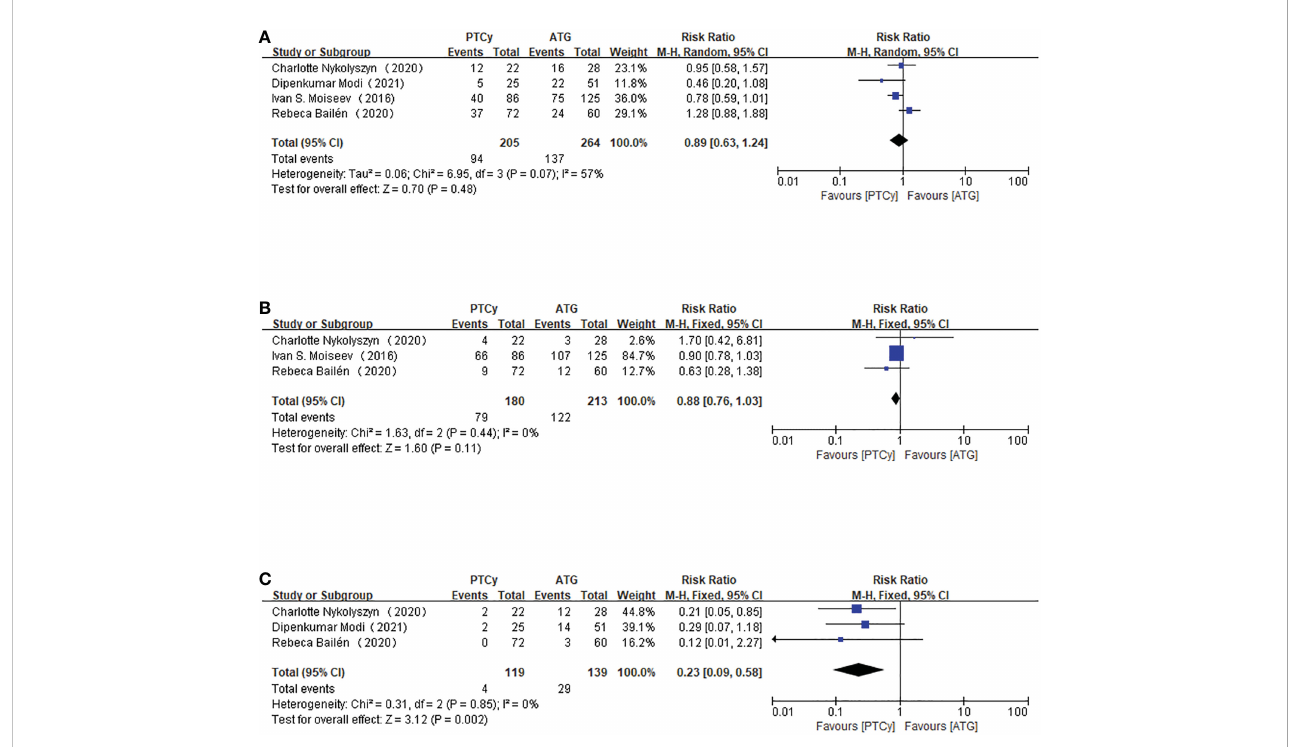
FIGURE 7 Forest plot of CMV reactivation (CMV disease) (A) , BKV-related HC (B) and EBV-related PTLD (C)